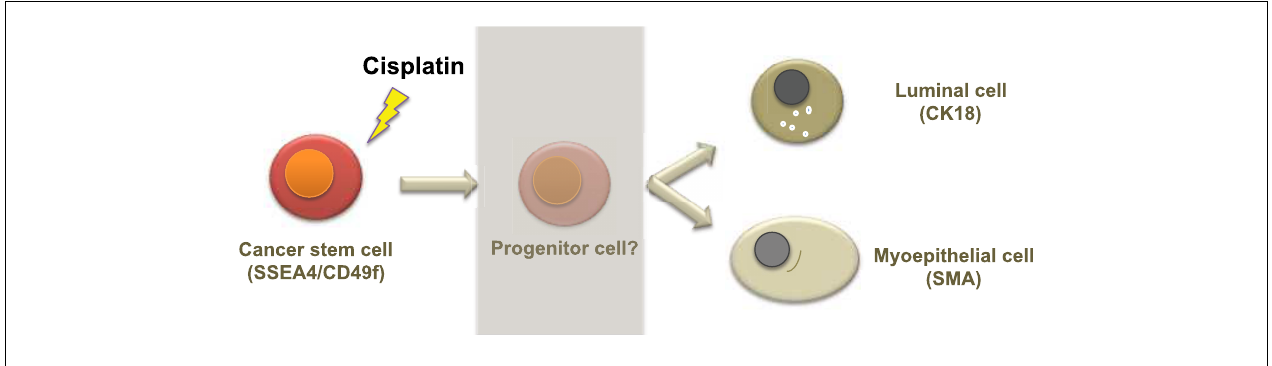
epithelial phenotype, luminal, or myoepithelial, which has lost or possesses limited proliferative potential. As the more differentiated cells are more susceptible to chemotherapy, this push of differentiation may assist in the management and/or treatment of breast